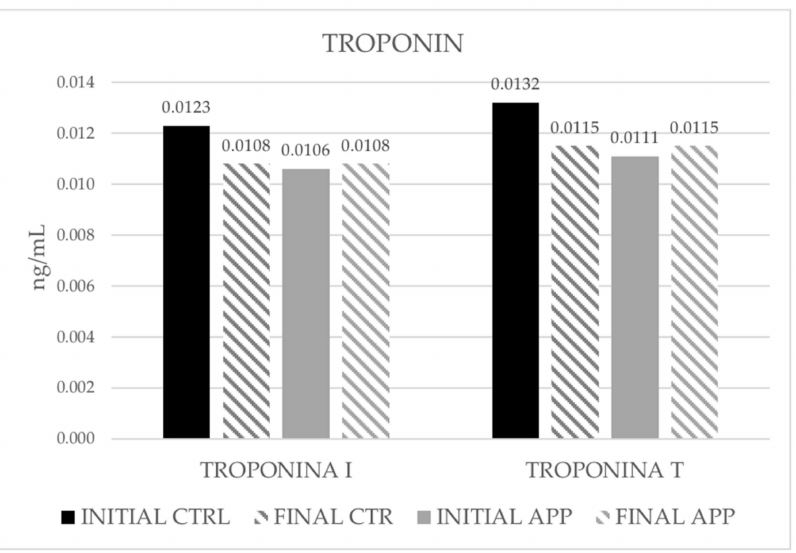
Figure 4. Descriptive (mean) of the variables troponin I and troponin T.